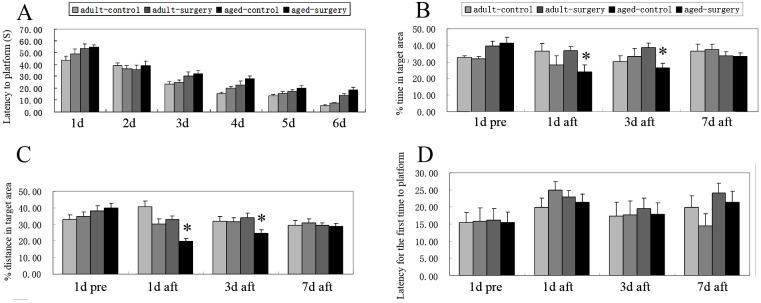
Hepatectomy differentially impaired the memory of young adult and aged rats.Latency to platform of young adult and aged rats both at control and surgery groups decreased with the increase of training days. No significant difference was detected between control and surgery groups of young adult and aged rats by repeated measures of ANOVA (P = 0.202 for aged; P = 0.057 for young adult) (A). During probe test of aged rats, repeated measures of ANOVA showed that the latency for the first entrance of targeted area wasn’t affected by surgery (P = 0.495), measure time (P = 0.067), and the interaction of surgery×measure time (P = 0.984) (D). Yet, percents of time (B) and distance (C) in the targeted area both were significantly affected by surgery (P = 0.045 for time; P = 0.041 for distance), measure time (P = 0.013 for time; P<0.001 for distance), and the interaction of surgery×measure time (P = 0.037 for time; P = 0.013 distance). Percents of time (B) and distance (C) in the targeted area of aged rats 1d (P = 0.006 for time; P<0.001 for distance) and 3d (P = 0.011 for time, P = 0.002 for distance) after surgery all were obviously less than that of 1d before surgery, respectively. For young adult rats, there was no obvious difference at the percent of distance in the targeted area (P = 0.170), the percent of time in the targeted area (P = 0.772) and the latency for the first entrance of targeted area (P = 0.938) between control and surgery groups 1d before surgery (A). Percents of time and distance, and the latency for the first entrance in the targeted area were not affected by surgery (P = 0.639 for time; P = 0.773 for distance; P = 0.983 for latency) and measure time (P = 0.327 for time; P = 0.358 for distance; P = 0.173 for latency) (B, C, D). 1d pre: 1d before surgery; 1d aft, 3d aft and 7d aft: 1d, 3d, 7d after surgery. Data were mean ± SEM. *p<0.05 vs 1d before surgery.